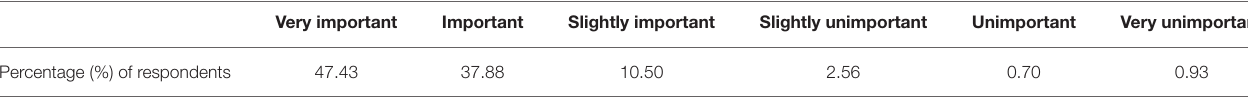
TABLE 7 | Responses to the question “How important do you think marine mammal conservation laws and policies are?”